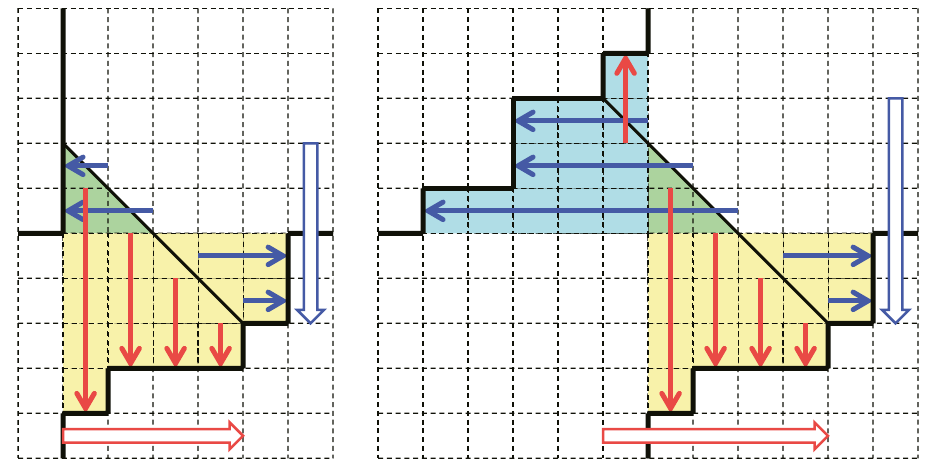
Figure 1 . Shifted Frobenius notation for M > 0. (Left) For a single Young diagram, the M -shifted Frobenius notation is given by counting the numbers of horizontal boxes and vertical boxes from the diagonal shifted by M . For the example of (cid:21) = [5 ; 5 ; 4 ; 1] and M = 2, the shifted Frobenius notation is given by ( A 1 ; A 2 j B 1 ; B 2 ; B 3 ; B 4 ) = (2 ; 1 j 5 ; 3 ; 2 ; 1). Since there are M more leg lengths than arm lengths, we supplement the M -shifted Frobenius notation by M auxiliary arm lengths as ( A 2 ; A 1 ; A 1 ; A 2 j B 1 ; B 2 ; B 3 ; B 4 ) = ( (cid:0) 1 ; (cid:0) 2 ; 2 ; 1 j 5 ; 3 ; 2 ; 1). We list the numbers in the order of the blank blue arrow and the blank red arrow. (Right) The introduction of the auxiliary arm lengths is naturally generalized to a composite Young diagram. For a composite Young diagram (cid:21)(cid:22) , we consider a pair of the rims and de(cid:12)ne the M -shifted Frobenius notation by the lengths from